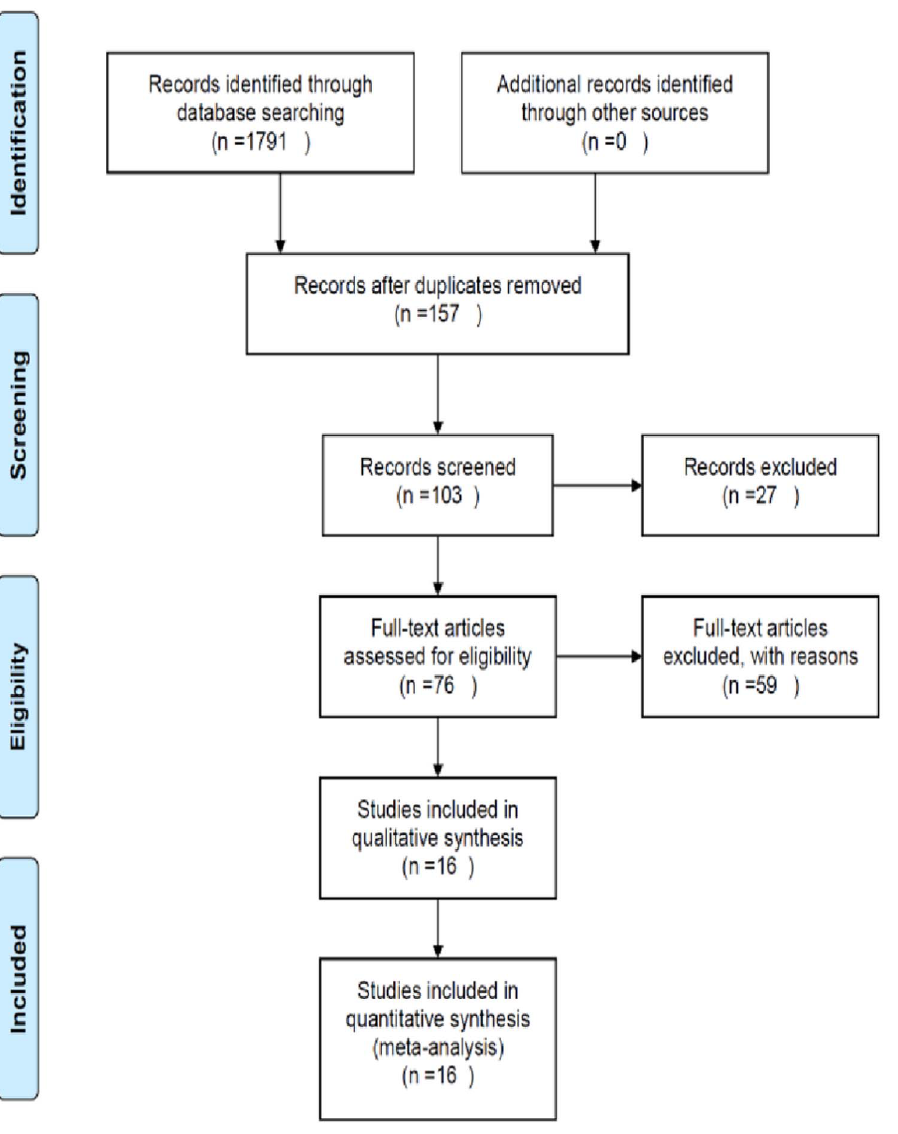
Figure 1. Search strategy outline. Flowchart demonstrating the search strategy used to identify articles for systematic review and meta-analysis of therapeutic hypothermia in animal spinal cord injury models.